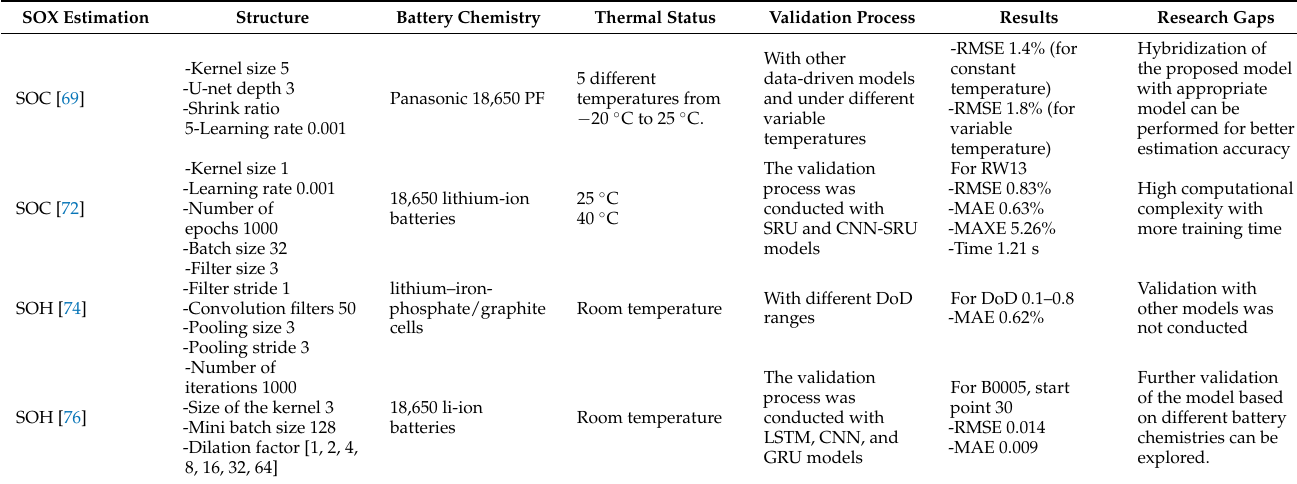
Table 5. Summary of CNN-based SOX estimation